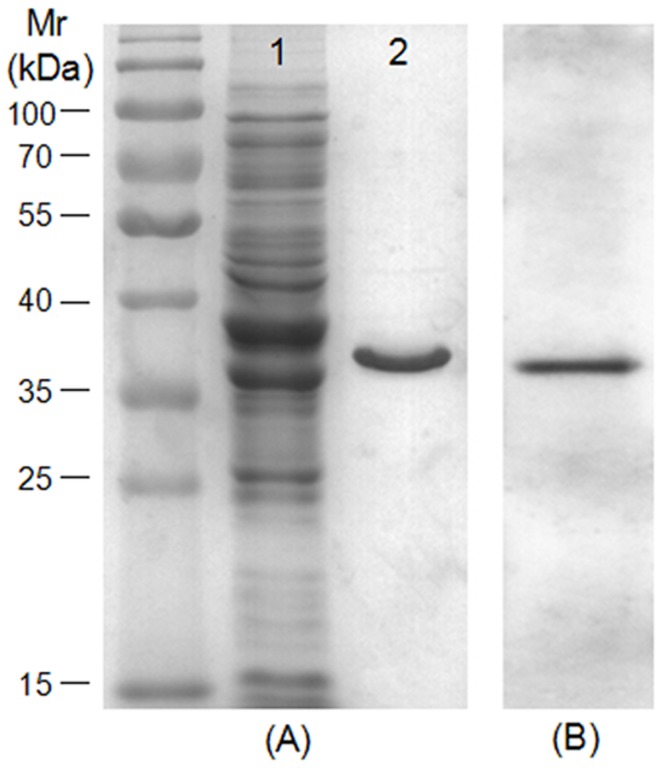
Extraction of the whole-cell proteins of M. bovis strain PD and expression of rPDHB protein.(A1) The extracted whole-cell proteins were separated by SDS-PAGE. (A2) Purity analysis of the recombinant His-tagged PDHB protein by SDS-PAGE. (B) Purified rPDHB protein was subjected to Western blot analysis using an anti-His-tag antibody.